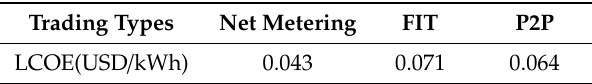
Table 14. LCOE by trading